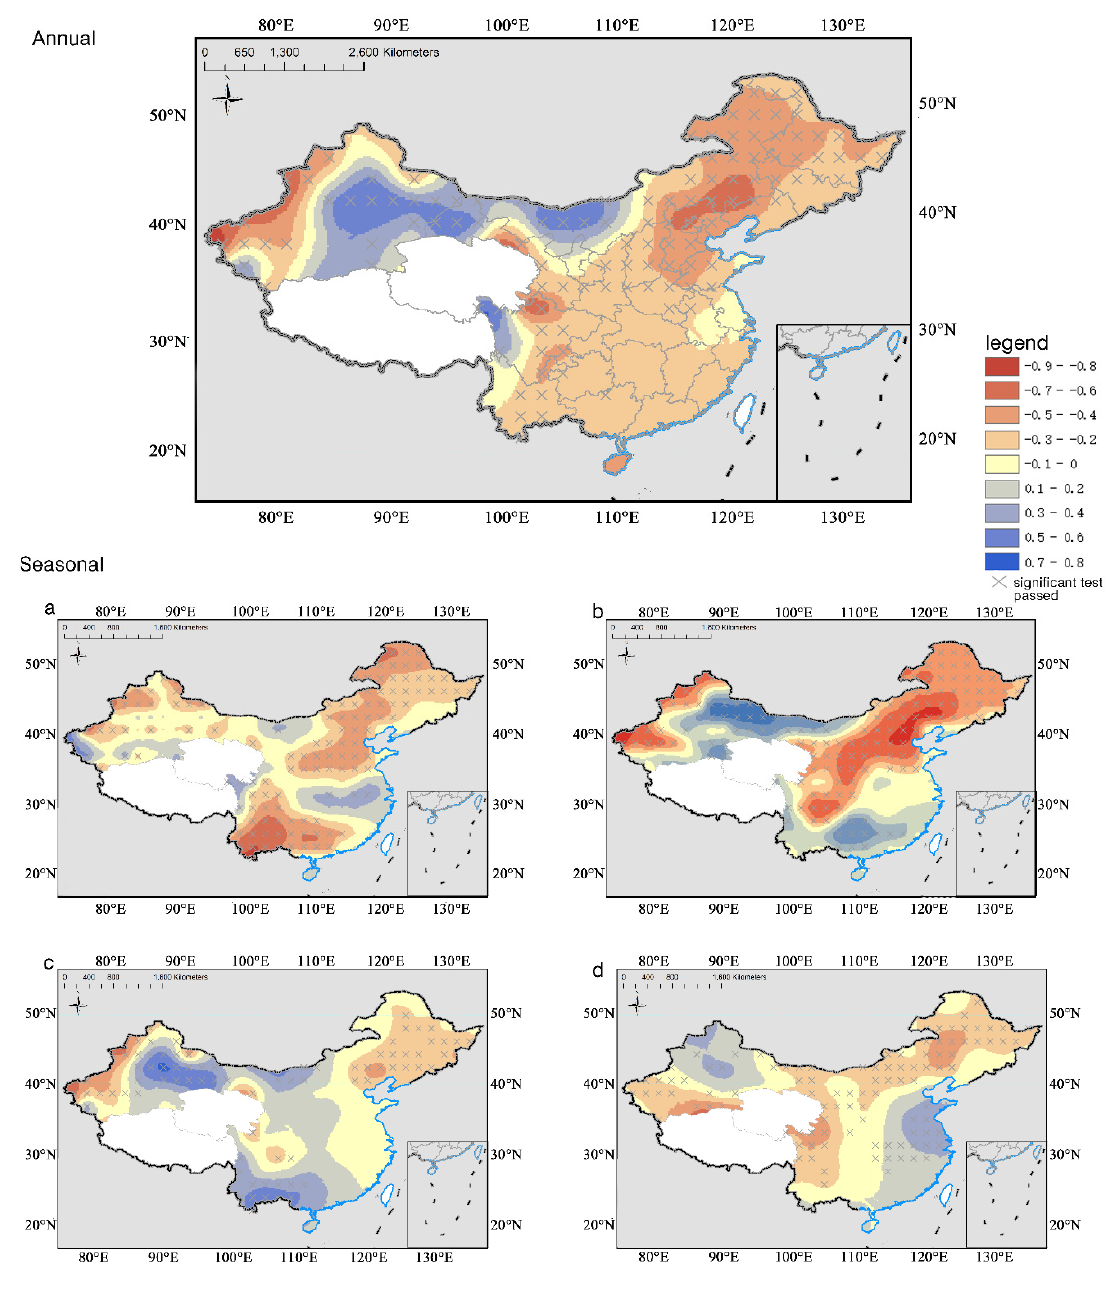
Figure 8. Distribution of correlation coefficient between annual and seasonal soil moisture and temperature. ( a ) Spring; ( b ) summer; ( c ) autumn; ( d ) winter.